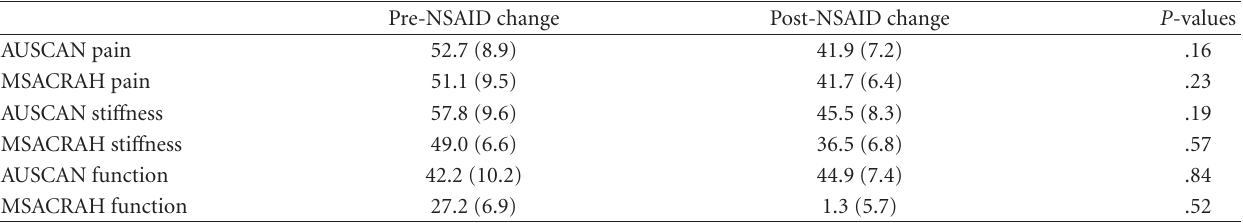
Table 4: Mean di ff erence (SEM = standard error of the mean) of domain scores before and after NSAID change due to ine ffi